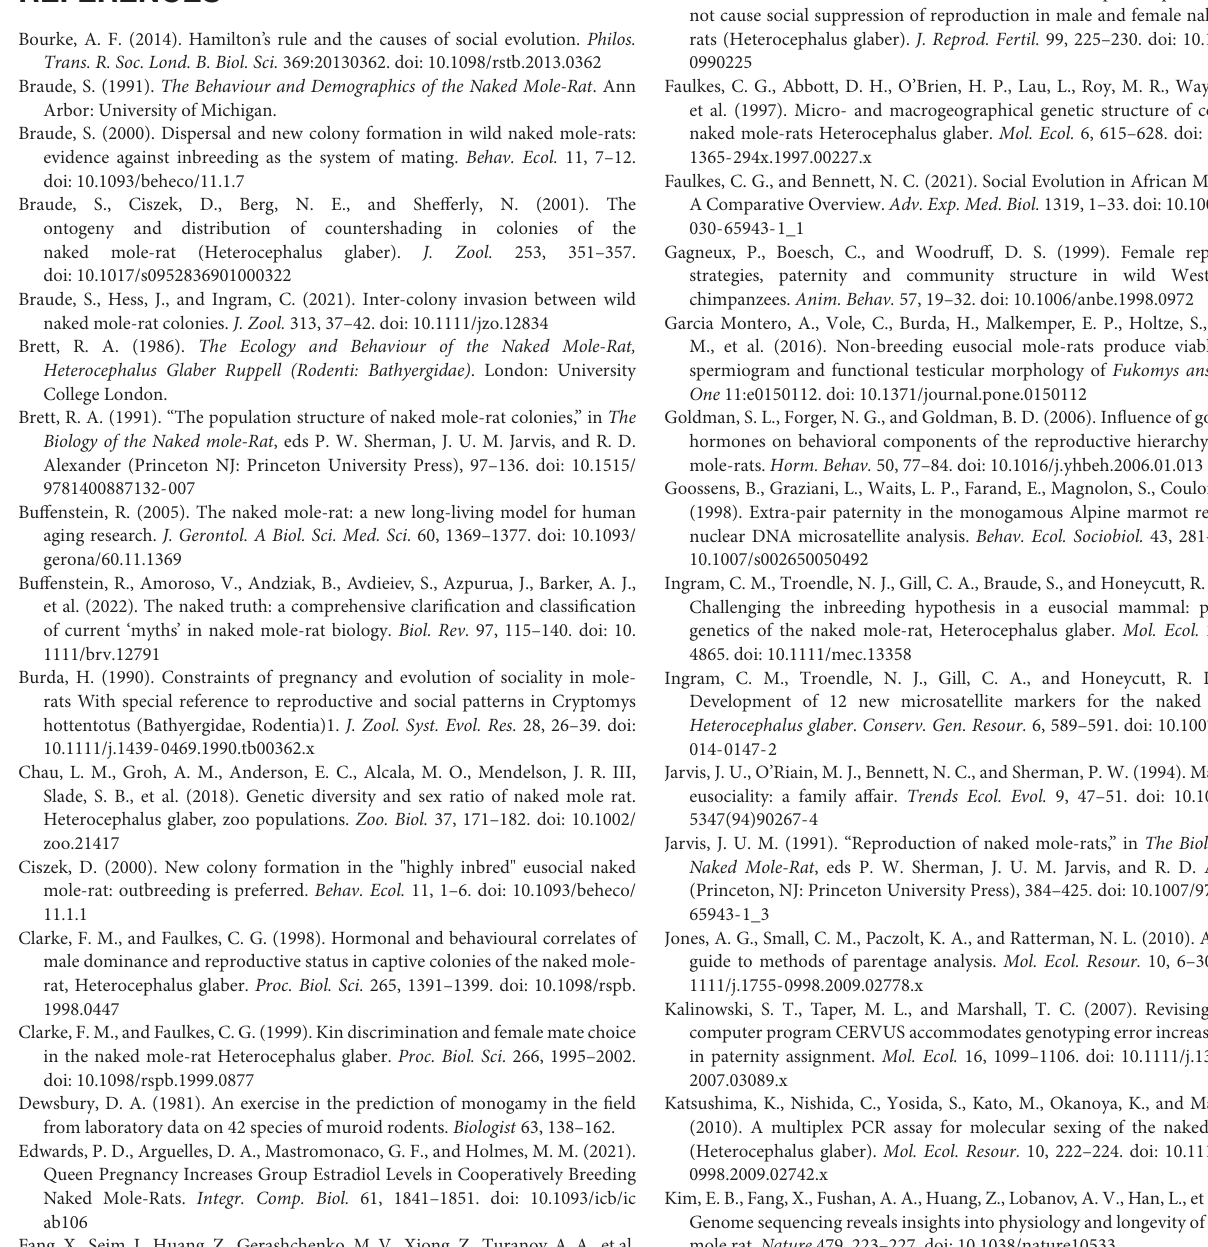
Supplementary Data File 1 | Genotyping data of colony B1, Cervus format. Supplementary Data File 2 | Genotyping data of colony B2, Cervus format. Supplementary Data File 3 | Genotyping data of colony V1, Cervus format. Supplementary Data File 4 | Genotyping data of colony V2, Cervus